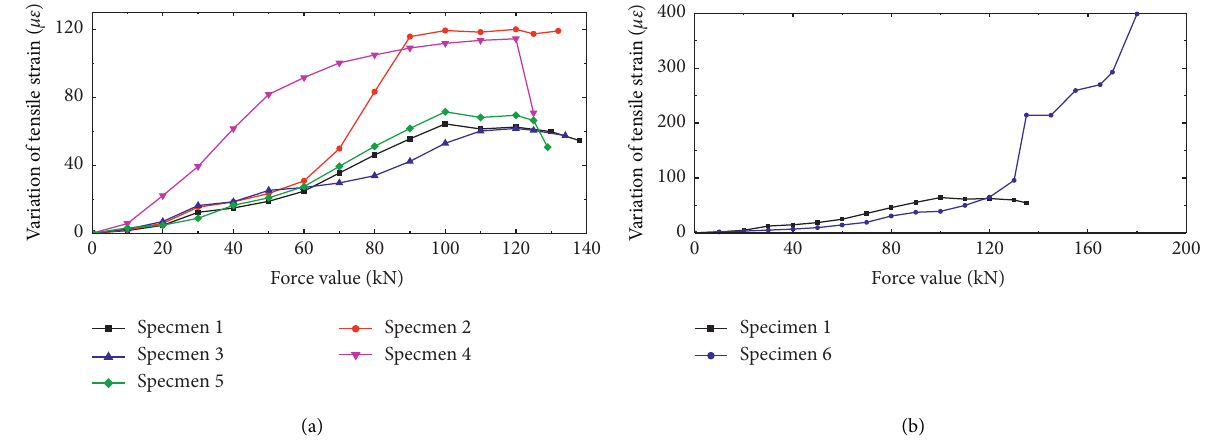
Figure 8: Change in strains of specimens 1 to 6:(a) specimens 1 to 5; (b) specimens 1 and 6.